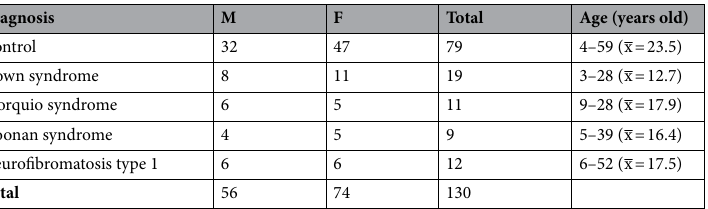
Table 1. Sample composition by diagnosis. The table provides the number of male (M) and female (F) participants, as well as the total sample size for each syndrome. The age range within each diagnostic group is also provided, where x represents the average